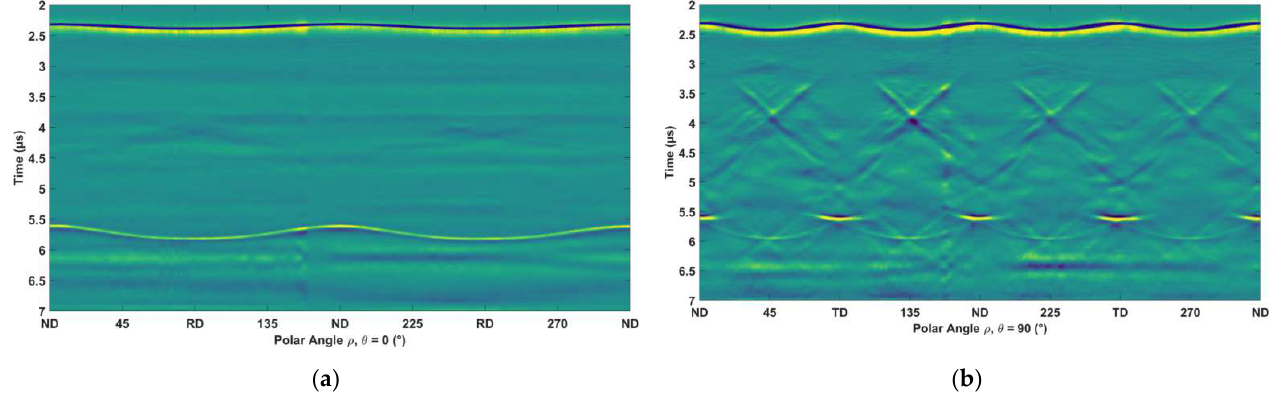
Figure 3. B-scans of the 70% deformed heat-treated 316 sample with rotation around the ( a ) TD and ( b ) RD axis.